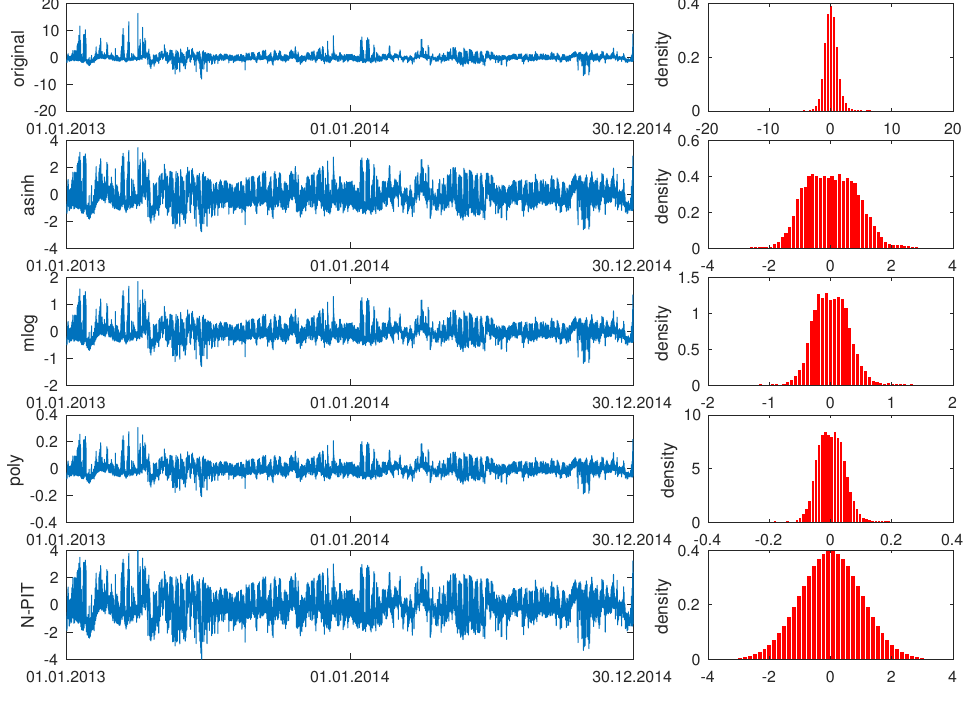
Figure 3. Time series plots of the original (in EUR/MWh), asinh -transformed, mlog -transformed, poly -transformed and N-PIT -transformed Nord Pool spot prices (from top to bottom). All series were deseasonalized with respect to the S 9 wavelet-based long-term seasonal component (LTSC) beforehand. The resulting marginal densities are depicted in the right